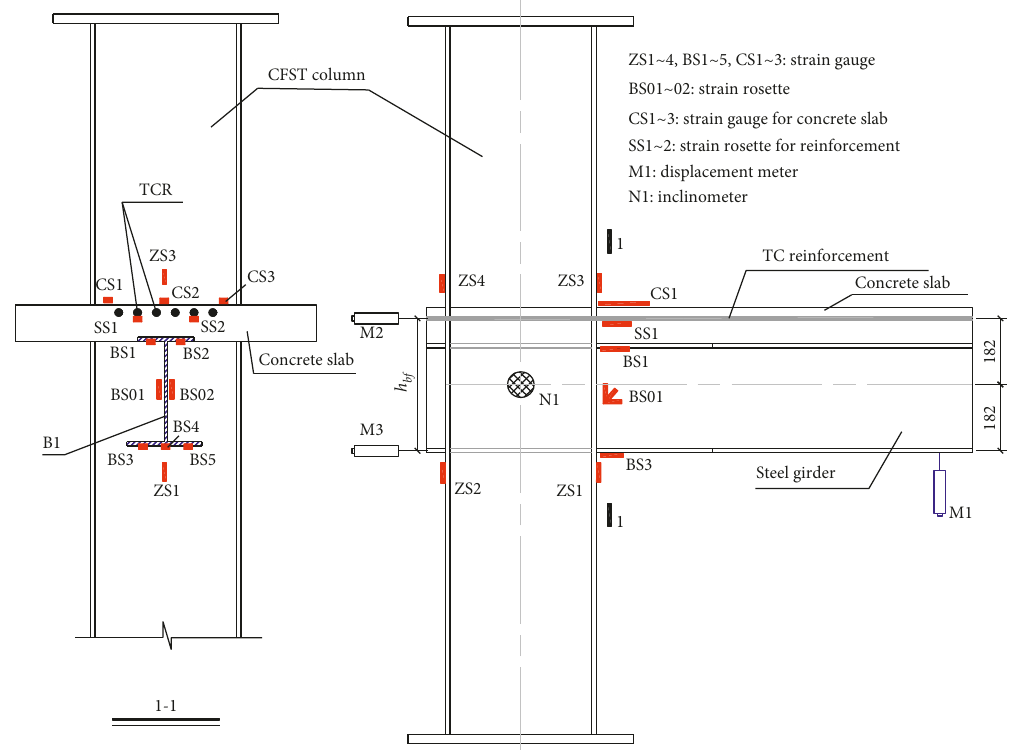
Figure 4: Arrangement of the measuring apparatus.